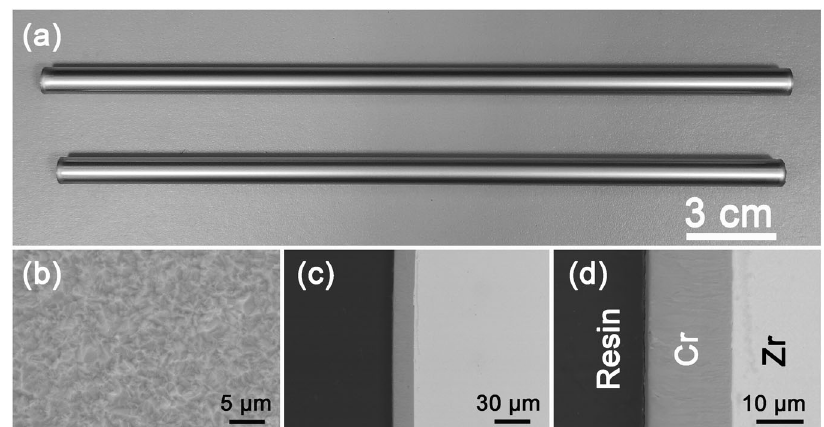
Fig. 1 Macroscopic and microscopic morphologies of the as-deposited Cr coating. a Sample image and SEM images of b surface and c cross-section.